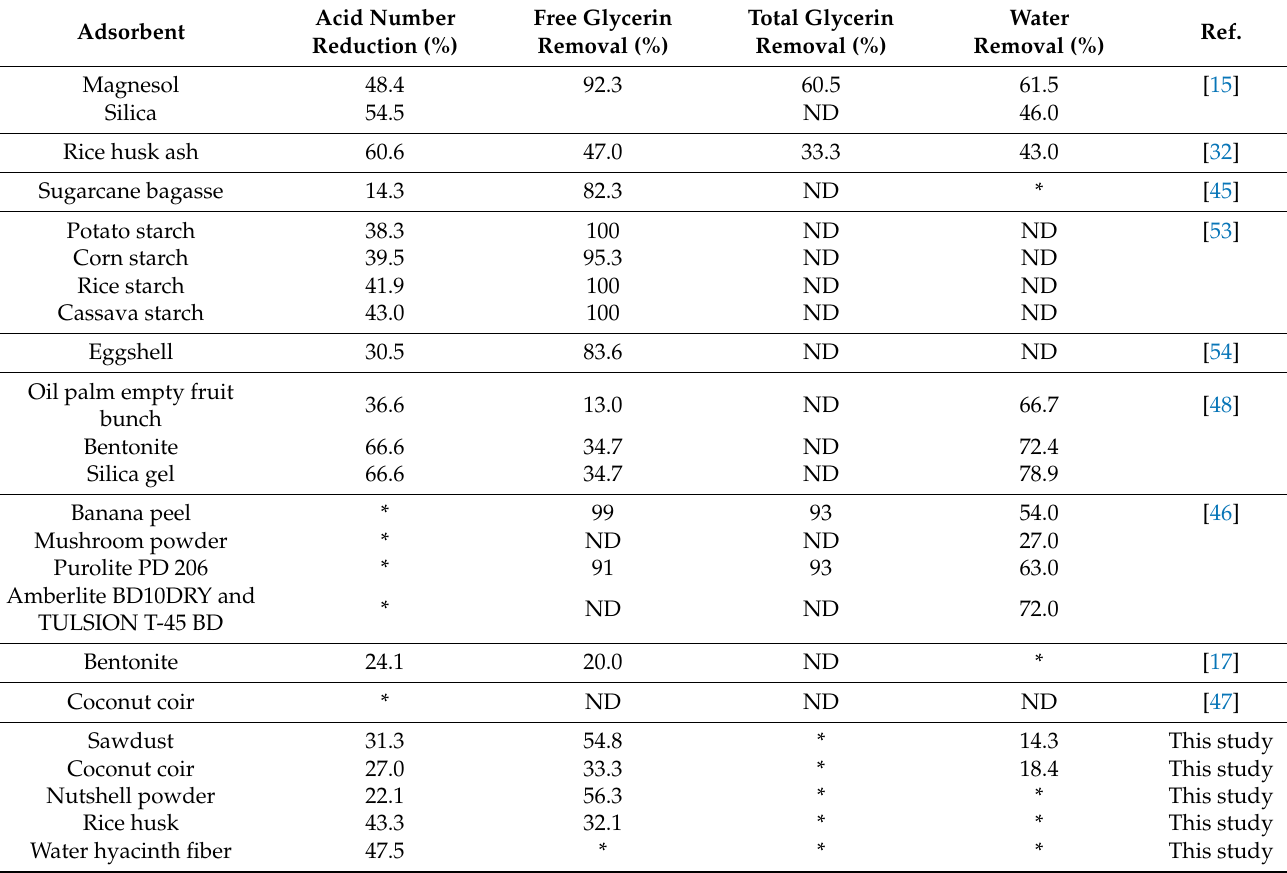
Table 2. Comparison of various studies that used adsorbents and bioadsorbents in biodiesel purification.